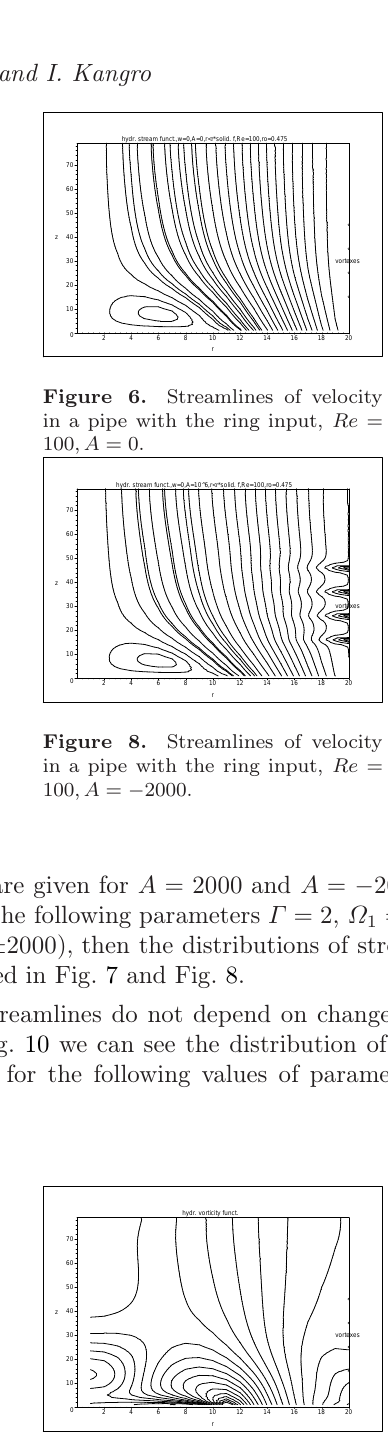
Figure 10. Distribution of the vor- ticity function with a ring input, A = 0 ,Re = 100 ,Ω 1 = 0 ,Ω 2 = 1